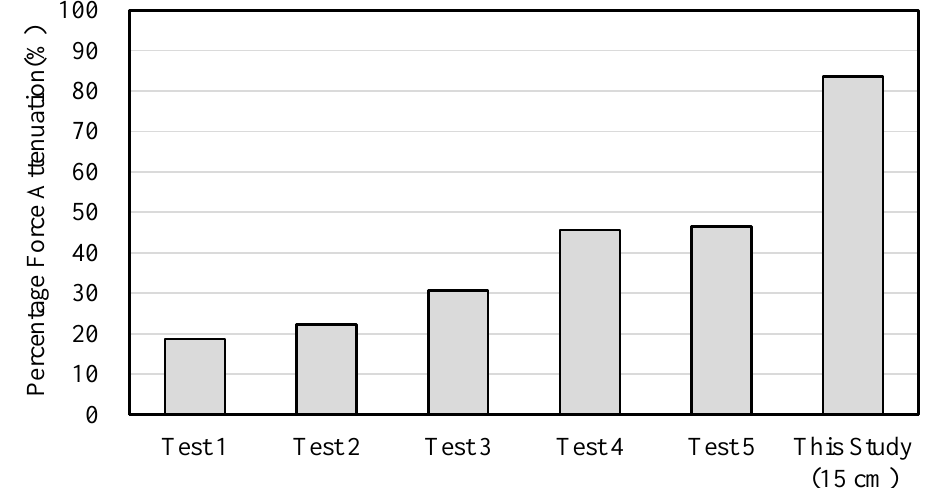
Figure 8. Percentage force attenuations. Tests 1, 2, 3, 4, and 5 were conducted with Safety Pants (Raunomo Oy, Tampere, Finland), Gerihip (Pervent Products, Inc., Rochester, MN, USA), Lyds Hip Protector (Lyds International BV, Velsen-Noord, The Netherlands), HipSaver (HipSaver, Inc., Norwood, MA, USA), and Safety Pants (Van Heek Medical, Venray, The Netherlands), respectively